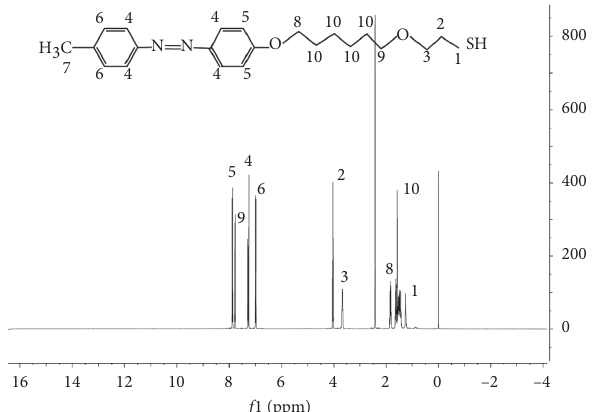
Figure 1: 1 H NMR spectra of Azo in chloroform- d (CDCl